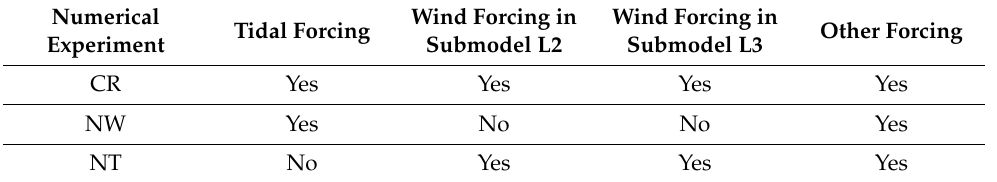
Table 1. List of four numerical experiments using the NGMS-seCS. Numerical